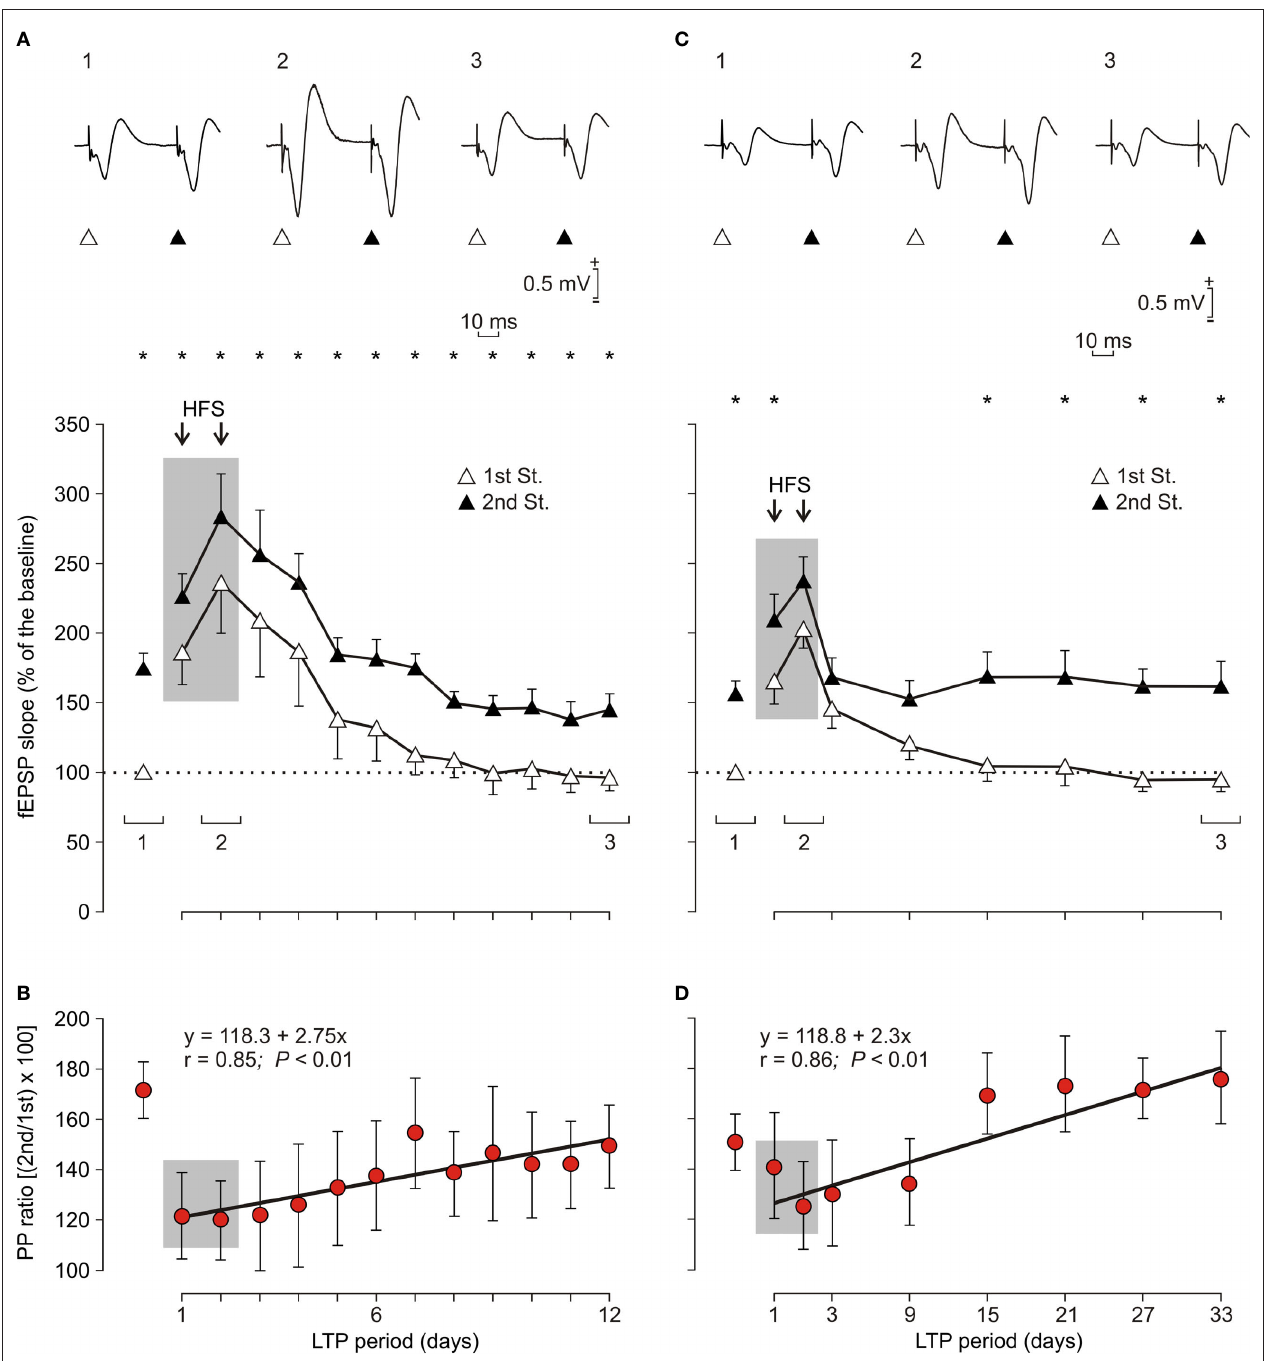
FIGURE 5 | Evolution of fEPSPs evoked in the CA1 area by paired-pulse stimulation of Schaffer collaterals before and after two HFS sessions. (A, C) For LTP induction, each animal was presented with two HFS sessions (see arrows and shaded area) each consisting of fi ve 200 Hz, 100 ms trains of pulses at a rate of 1/s. This protocol was presented six times, at intervals of 1 min. The 100 µs, square, biphasic pulses used to evoke LTP were applied at the same intensity used for the single pulse presented following HFS presentation. The evolution of LTP was checked using a pair of pulses (1st, white triangles; 2nd, black triangles) with an inter-stimulus interval of 40 ms. Recordings was carried out for 12 days ( A , n = 10 animals) and 33 days ( C , n = 10 animals). At the top